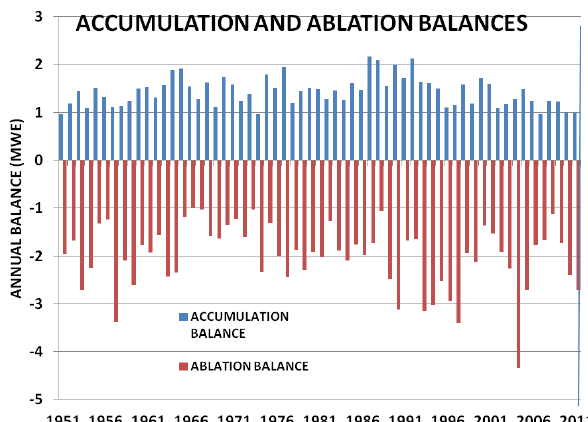
Figure 6. Accumulation and Ablation Balances for the 1951-2011 266 Fig. 6. Accumulation and ablation balances for the 1951–2011 pe- period. The average annual Accumulation balance for this period is +1.4 267 and the average Ablation balance is –2.0 (mwe). Maximum ablation (- 268 riod. The average annual accumulation balance for this period is 4.3 mwe) occurred in 2004. 269 +1.4 and the average ablation balance is − 2.0 (mw.e.). Maximum 270 ablation ( − 4.3mw.e.) occurred in